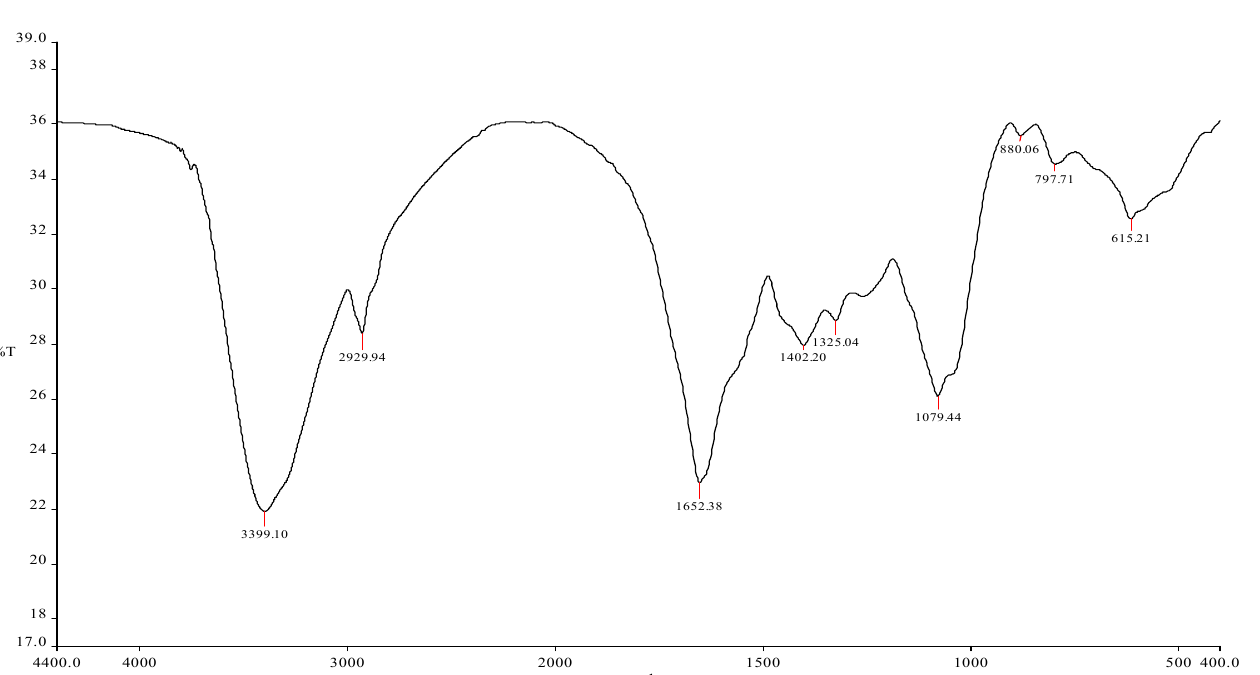
Figure 6. FTIR spectrum of O. majorana aqueous leaf extract.